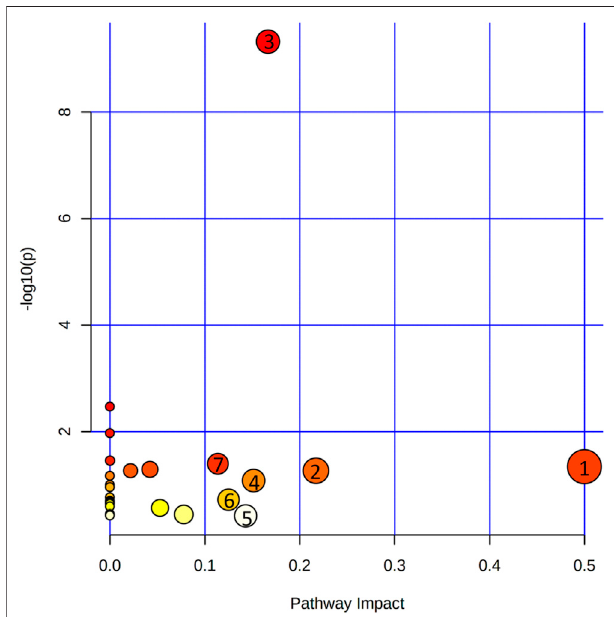
FIGURE10 | Metabolic pathwaysinvolved inthe treatment ofXS volatile oil on OVX rats. (1) Phenylalanine, tyrosine, and tryptophan biosynthesis; (2) glycine, serine, and threonine metabolism; (3) aminoacyl-tRNA biosynthesis; (4) tyrosine metabolism; (5) tryptophan metabolism; (6) Pentose and glucuronate interconversions; (7) alanine, aspartate, and glutamate metabolism.